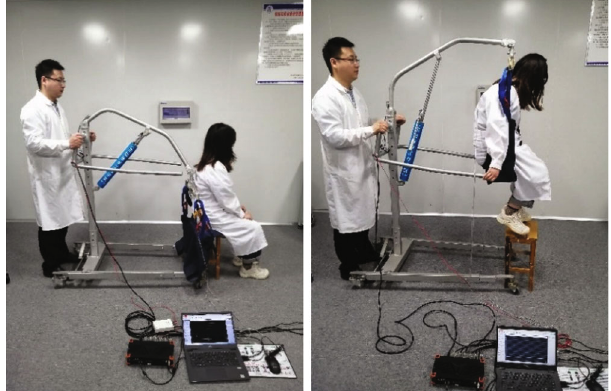
Figure 8: Dynamic mechanical signal experiment of existing patient transfer device prototype.